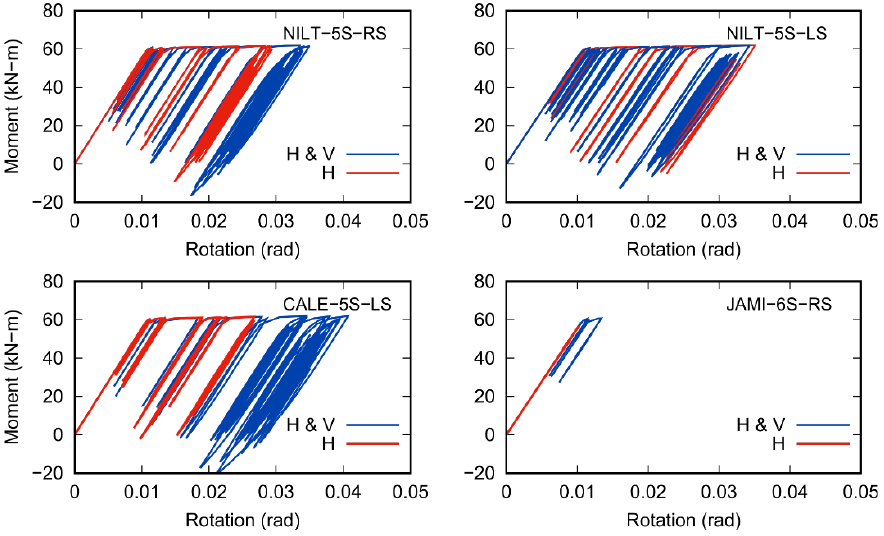
Figure 7. Non-linear response of the outer-most fiber in different beams for different earthquakes; 6-story buildings (Part 1).